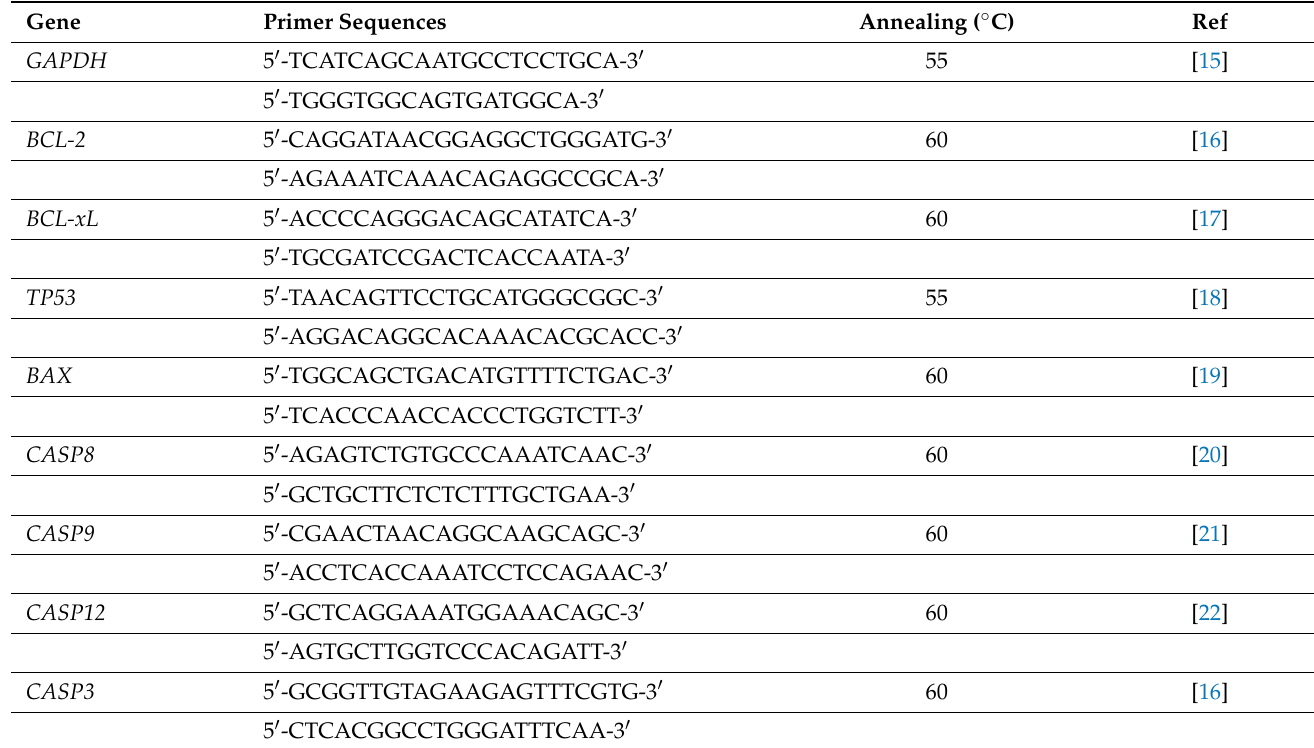
Table 1. Primer sequences used in